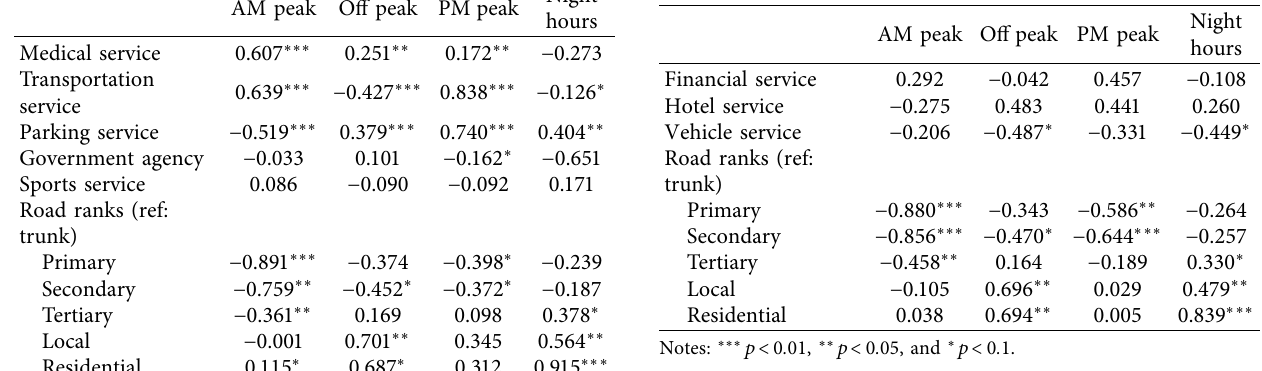
Table 9: Impact of fnancial, hotel, and vehicle service POIs on road congestion.